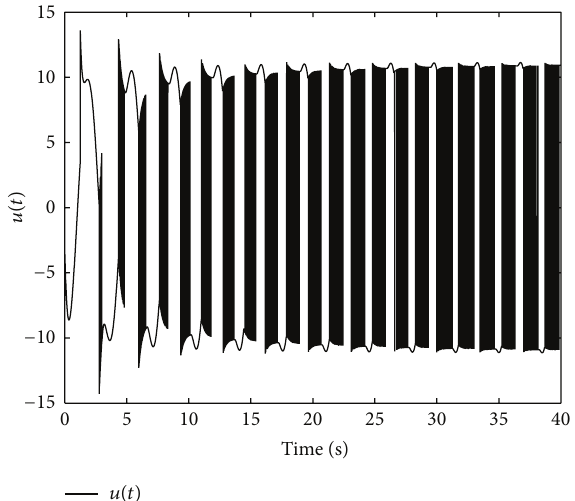
Figure 3: Time response [𝑦, ̇𝑦] 𝑇 of system (1) under the method of [21].